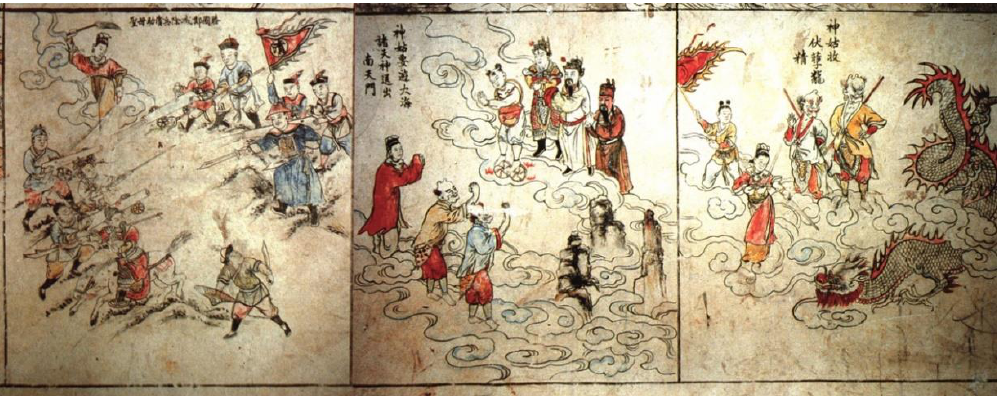
Figure 3. Three murals on the side wall of the Mazu Temple in Fengting. Source: Photo by Dr. Klaas Ruitenbeek, researcher at the University of Munich, 1991.